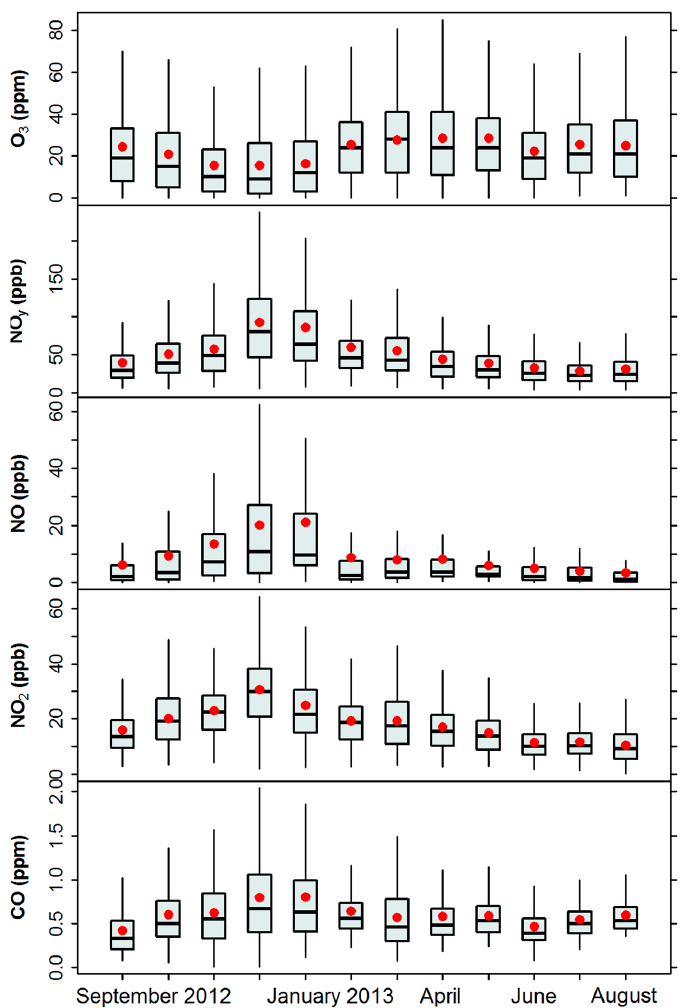
Figure 4. Annual profile of air pollutants recorded at the OBI site during September 2012 to August 2013. The horizontal black line shows monthly medians, and the red dots show monthly averages.